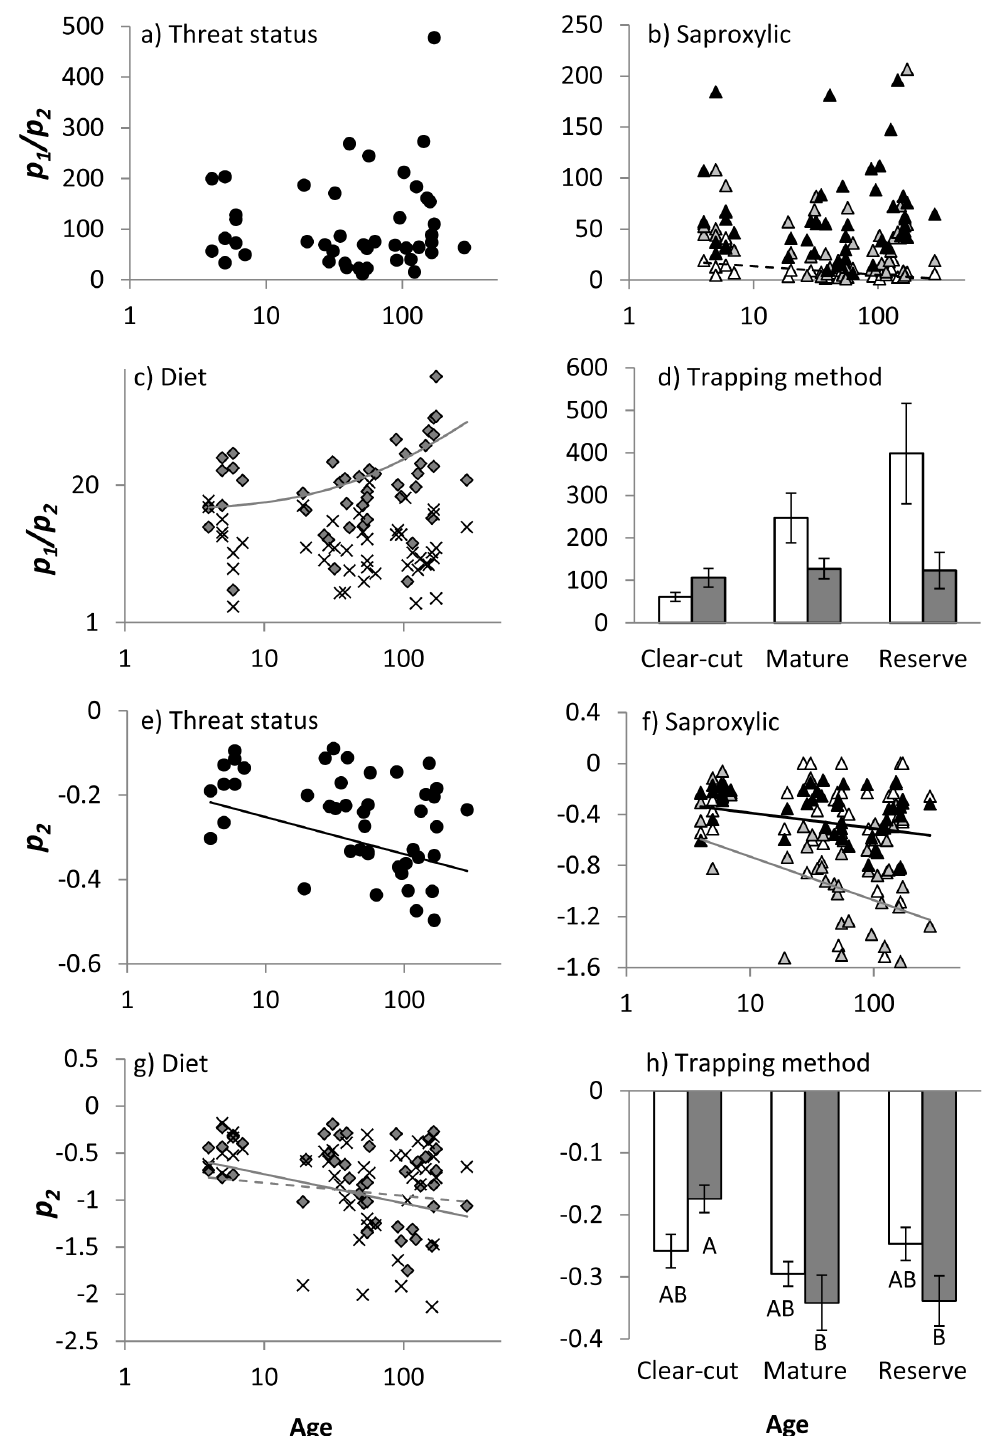
Figure 3. Relationships between stand age and Mouillot and Lepretre’s (1999) derived parameters for the Zipf-Mandelbrot distribution for beetle functional groups based on: a) and e) threat status; b) and f) degree to which species are dependent on dead wood; c) and g) diet; and d) and h) trapping method. Functional groups where several age classes supported less than twenty species (red-listed species, detritivores and cambium consumers) were excluded. Symbols as for Figure 1. Only significant or near-significant regression lines are shown. Lines may appear curved due to the log scale of the y-axis. doi: 10.1371/journal.pone.0072764.g003 PLOS ONE |